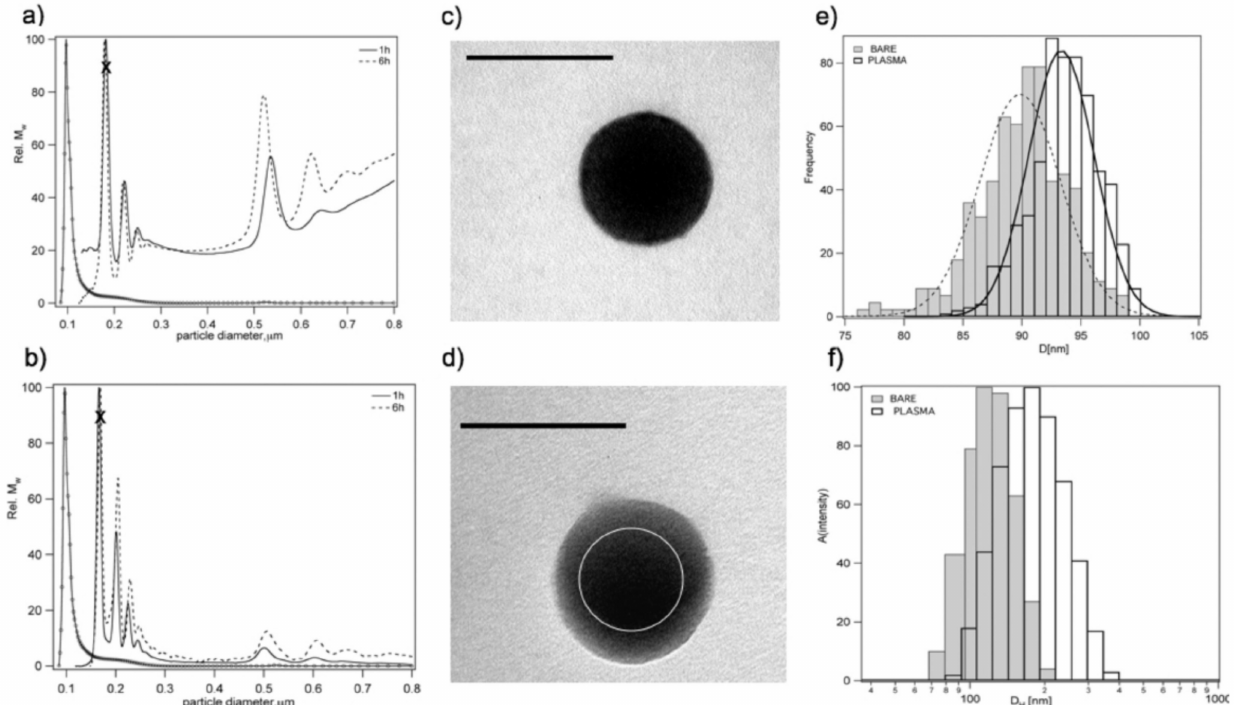
Figure 4. ( a ) Differential centrifugation sedimentation results (DCS) for 100 nm PSCOOH NP–protein complexes in plasma measured after 1 h (solid line) and 6 h (dotted line) of incubation. ( b ) DCS results for particle–corona complexes free from excess plasma 1 and 6 h after in PBS. Bare = 100 nm. PSCOOH NPs in PBS (open circles) for reference in both graphs. The marked peaks relate to the monomeric NP–protein complexes. ( c ) Transmission electron microscopy (TEM) picture of bare 100 nm PSCOOH nanoparticles. Bar = 100 nm. ( d ) TEM picture of the protein–particle complex (free from excess plasma) for 100 nm PSCOOH NPs. ( e ) Size distribution histogram by size analysis of various TEM images of particles. ( f ) Dynamic light scattering (DLS) intensity-weighted size distributionfor 100 nm PSCOOH NPs (bare) and 100 nm PSCOOH protein–particle complexes free from excess plasma (washed corona) in PBS. Adapted, with permission, from [19]. Copyright (2020) American Chemical